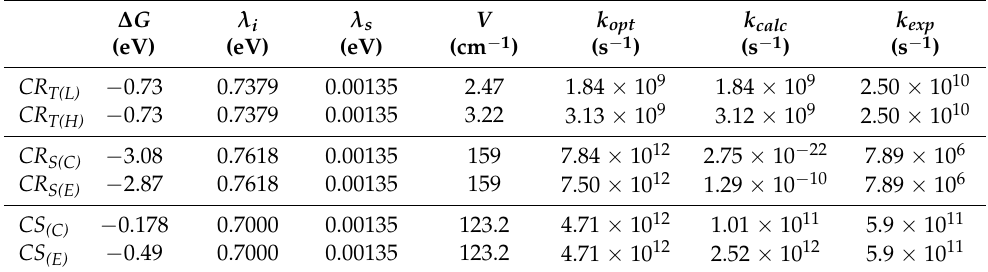
Table 10. Parameters for rate determination at T = 295 K in n-hexane (NHX) using the Classical Marcus